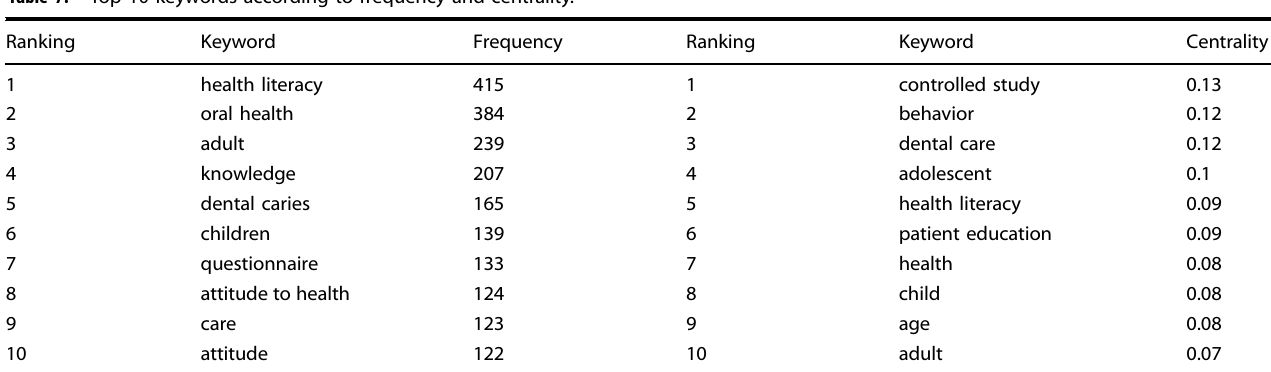
Table 7. Top 10 keywords according to frequency and centrality.